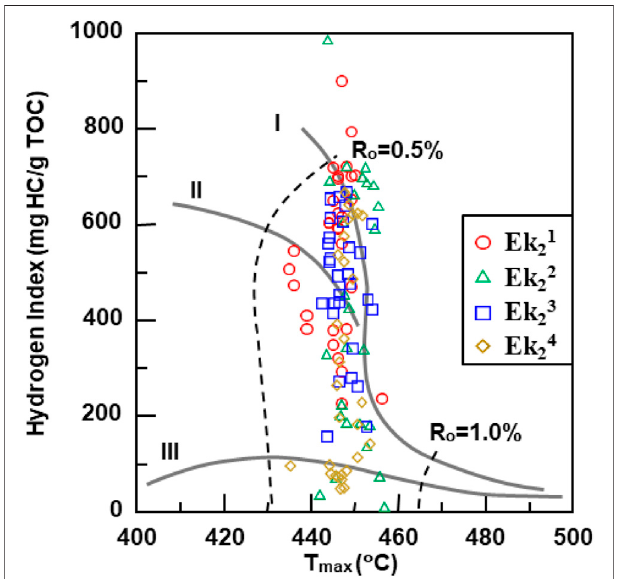
FIGURE 3 | The plot of HI versus the T max for the Ek 2 samples, showing the kerogen quality and the thermal maturity stages (modi fi ed after Mukhopadhyay et al. (1995)).